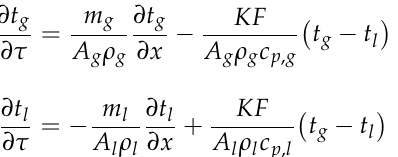
liquid temperatures, respectively ( ◦ C), A g and A l are the cross–sectional area on the gas side and liquid side, respectively (m 2 ), K is the heat transfer coefficient of the heat exchanger in W/(kg · ◦ C), F is the heat exchange area per unit length (m 2 ), ρ g and ρ l are the gas and liquid density, respectively (kg/m 3 ), c p,g and c p,l are the average specific heat of the gas and liquid, respectively, in kJ/(kg · ◦ C). Equations (10) and (11) constitute the dynamic mathematical model of the heat exchanger, and they can be solved by the finite difference method [42].